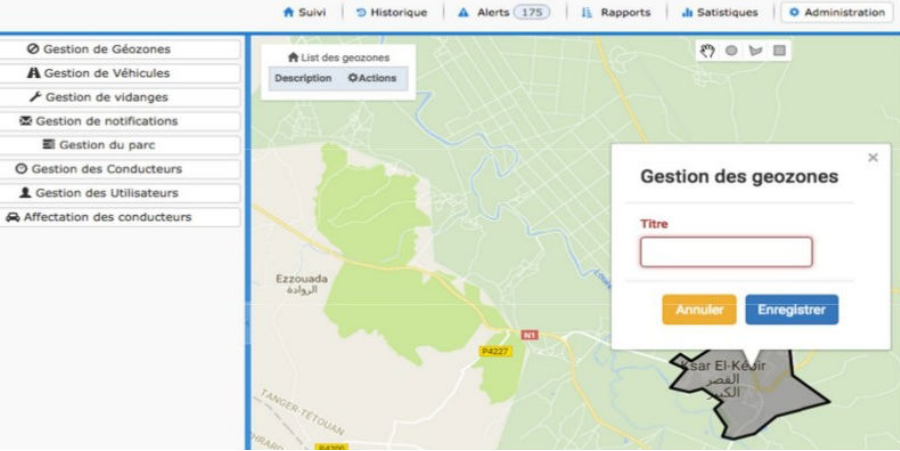
Figure 9. Geo-zone restriction.